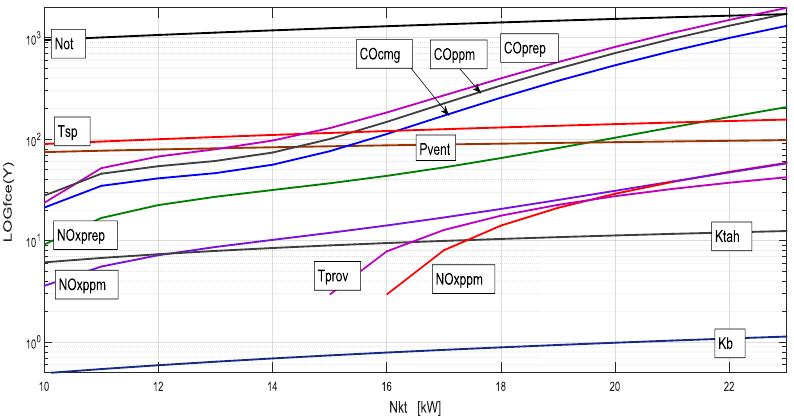
Figure 7. Method of power output regulation for gasification boiler MAGA 23 according to the technical solution.